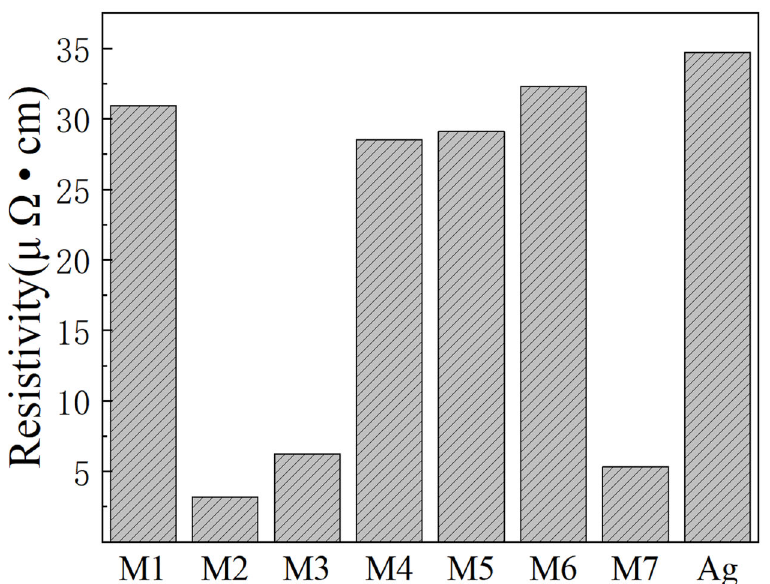
Figure 10. Resistivity of different Ag paste-sintered films.